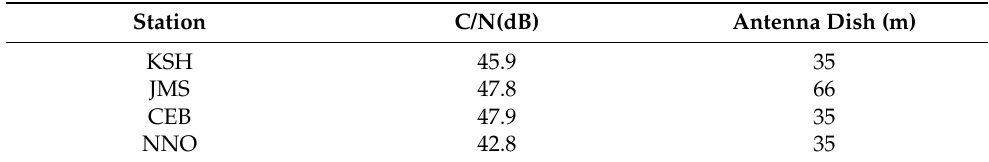
Figure 11. Spacecraft signal received at each station: ( a ) JMS; ( b ) KSH; ( c ) CEB; ( d ) NNO. The C/N of each station is listed in Table 3. It could be identified that the C/N value of JMS is 3~4 dB higher than KSH, which is approximate to the designed G/T difference value, as expected. While the C/N of KSH is about 5 dB lower than that of the ESA deep space antennas, they are basically the same. Table 3. C/N statistics of each station.